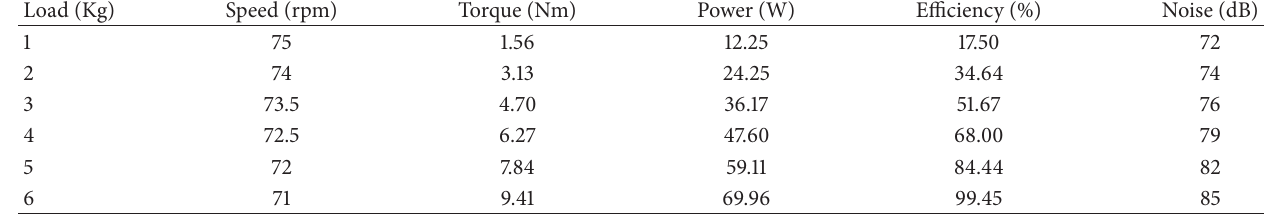
Table 15: Observations with phasing arrangement.